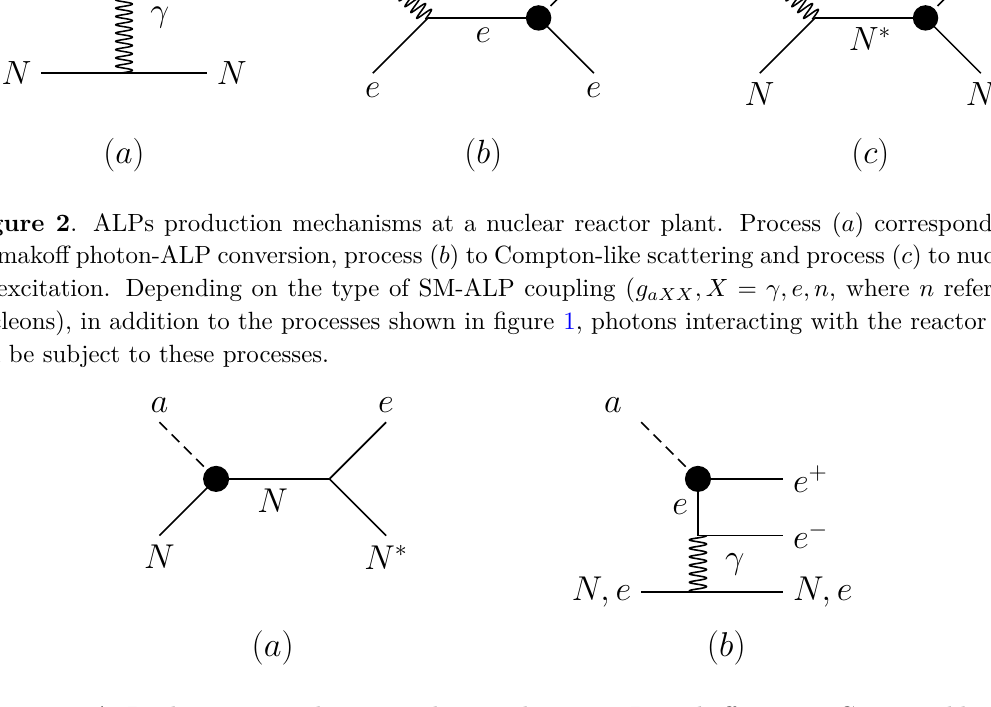
Figure 3 . ALPs detection mechanisms, along with inverse Primakoff, inverse Compton-like and nuclear excitation (inverse processes in figure 2). Process ( a ) corresponds to the axio-electric process (photo-electric absorption equivalent, diagram ( c ) in figure 1), while process ( b ) to axion e -pair production ( e -pair production in the field of the nucleus or electron equivalent, diagram ( d ) in figure 1). As in the production case, whether such detection mechanisms are operative depends on the type of coupling the analysis is subject to. See table 2 for